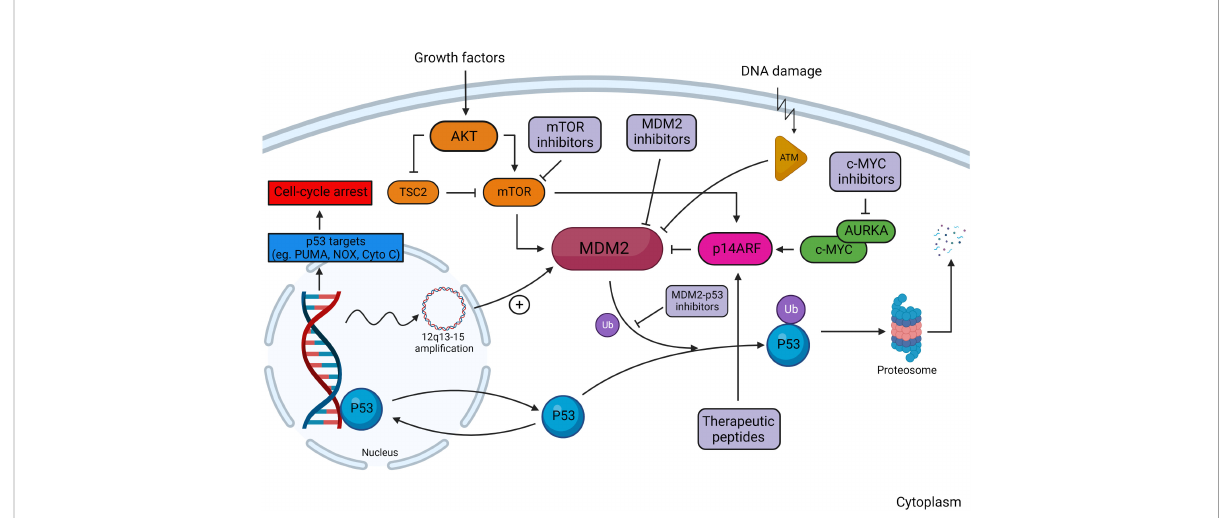
FIGURE 3 Overview of the MDM2 – p53 pathway in response to DNA damage. In the absence of DNA damage, MDM2 facilitates ubiquitination of p53, tagging it for proteosomal degradation. Damage to DNA activates kinases, including ataxia telangiectasia-mutated (ATM) kinase, which are responsible for phosphorylating MDM2 and reducing its af fi nity to bind cytosolic p53. Regulators of the MDM2 – p53 interaction include the AKT/ mTOR pathway, ARF, and c-MYC. Downstream transcriptional targets of p53 serve to arrest cell-cycle progression and induce cellular apoptosis. Multiple sites of action are targeted by MDM2 and MDM2 – p53 inhibitors, which decrease p53 degradation in tumors with wild-type p53. Created with